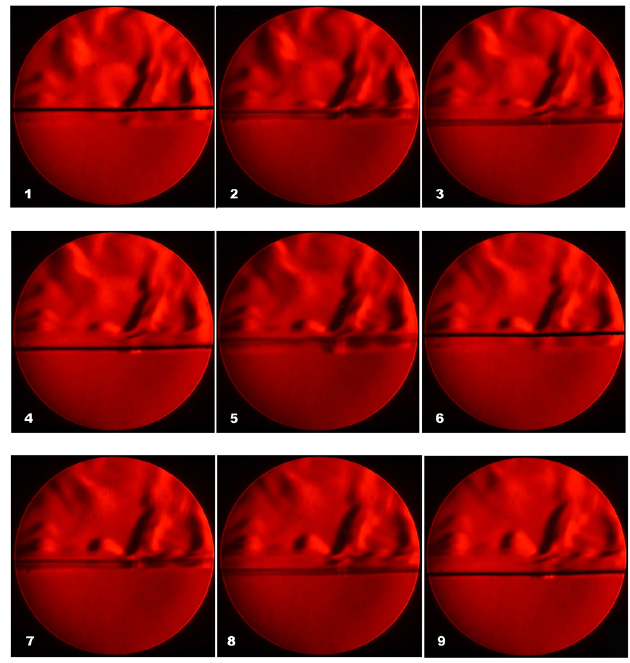
Figure 7. Time-sequence of images at intervals of 40 ms showing the convection flow and the spatial position of the wire heater during TMO [(Cr20Ni80)-wire of thickness d = 0.5 mm; pulsation of stress ∆ σ = 8 MPa; ν = 5.4 Hz, modulation frequency ν = 5 Hz; 2 A = 10 mm]. Subfigures 1 – 9 show 0 two periods of the heater motion from its upper position (subfigures 1 and 6 ) to the lower position (subfigures 4 and 9